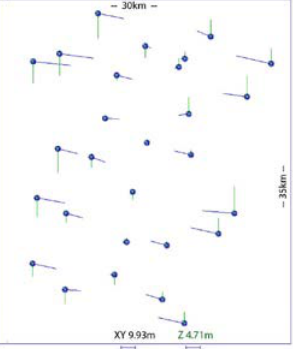
Figure 1. Discrepancies at check points, Cartosat-1, Warsaw, based on RPC-orientation with bias correction by shift, green vectors (vertical direction) = height